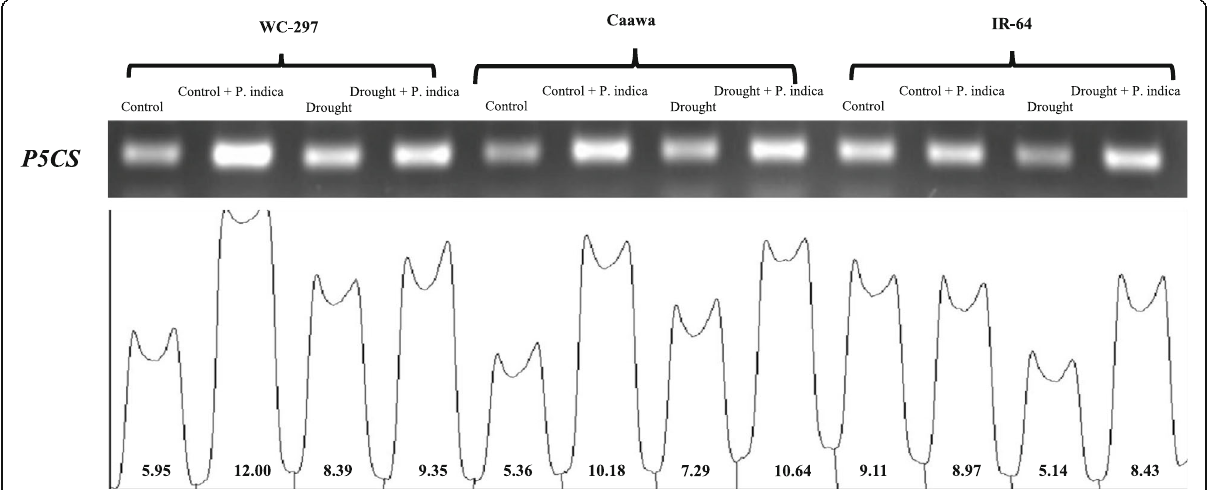
Fig. 4 Change in the expression pattern of P5CS . P. indica increased the expression of P5CS both in the presence and absence of osmotic stress.